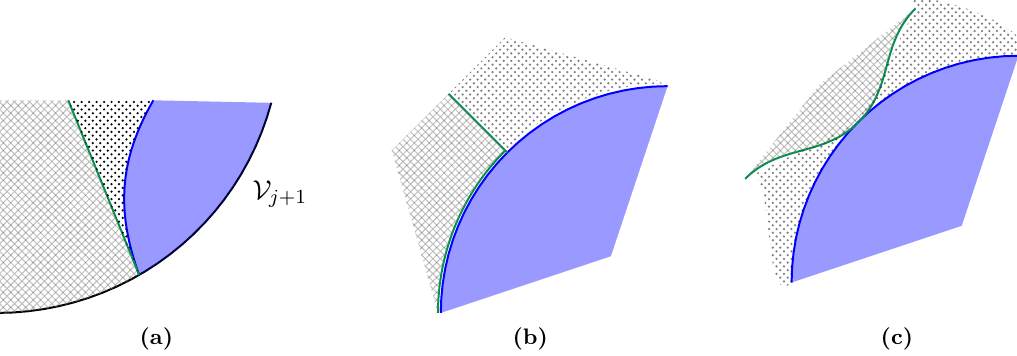
Figure 13. The three ways described in the text that a dividing curve can meet a component of γ V . In (a), it meets γ V at the left endpoint of V j and terminates. In (b) there is a direction along γ V that lies outside I − ( E ) , and the dividing curve continues in that direction. In (c) the dividing W j curve bounces off of γ and continues in the interior of F V